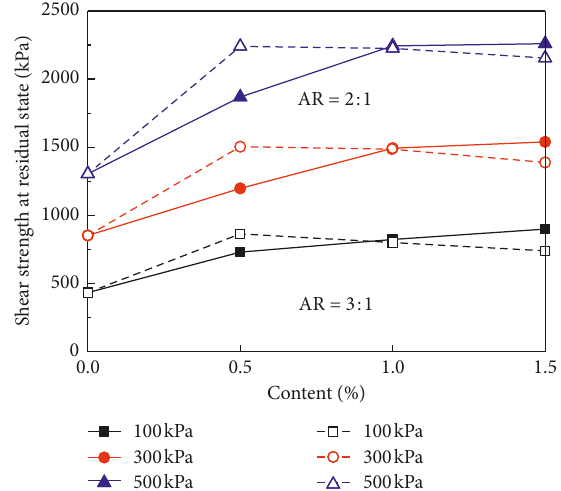
Figure 4: Variations in residual strength under the effects of fabric block content and aspect